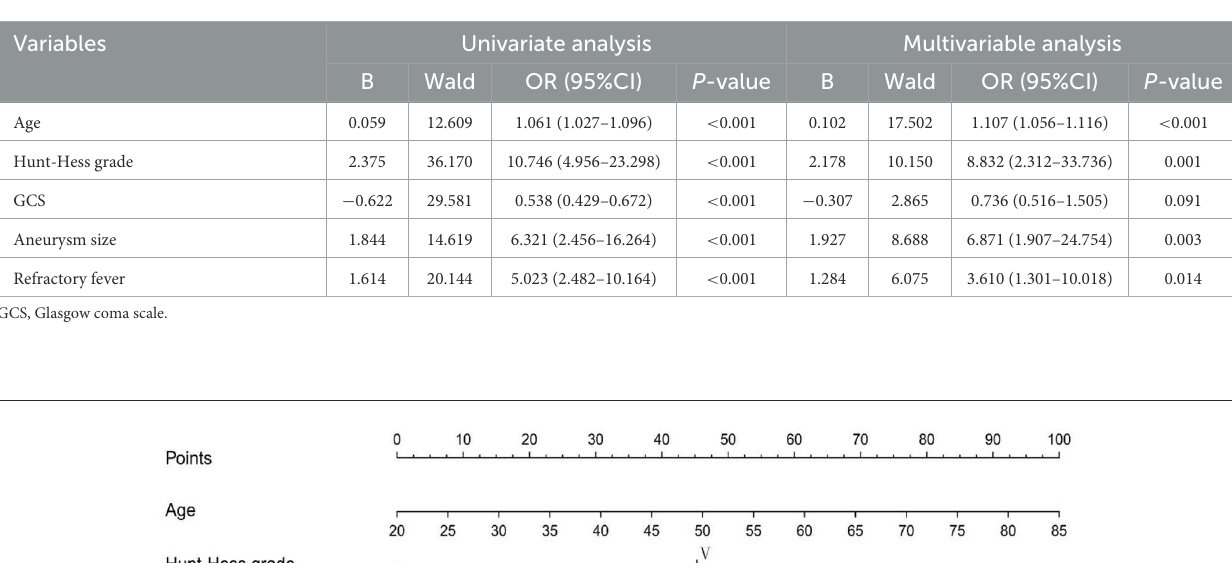
TABLE 2 Univariate and multivariable logistic analysis.